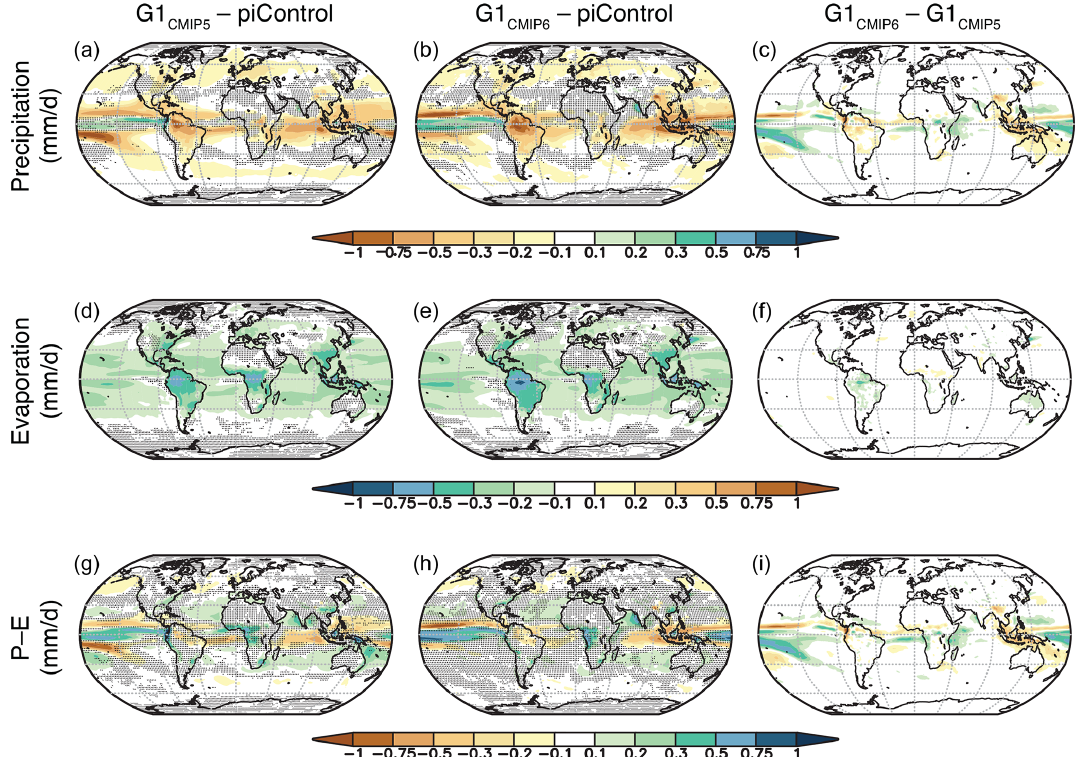
Figure 9. Precipitation (a–c) , evaporation (d–f) , and precipitation minus evaporation ( P – E ; g–i ) change from pre-industrial values for the CMIP5 (a, d, g) and CMIP6 (b, e, h) ensembles, as well as the ensemble differences (c, f, i) . All shaded values are ensemble means. Lack of stippling in the left and middle panels indicates agreement on the sign of the values across at least 75% of the models.